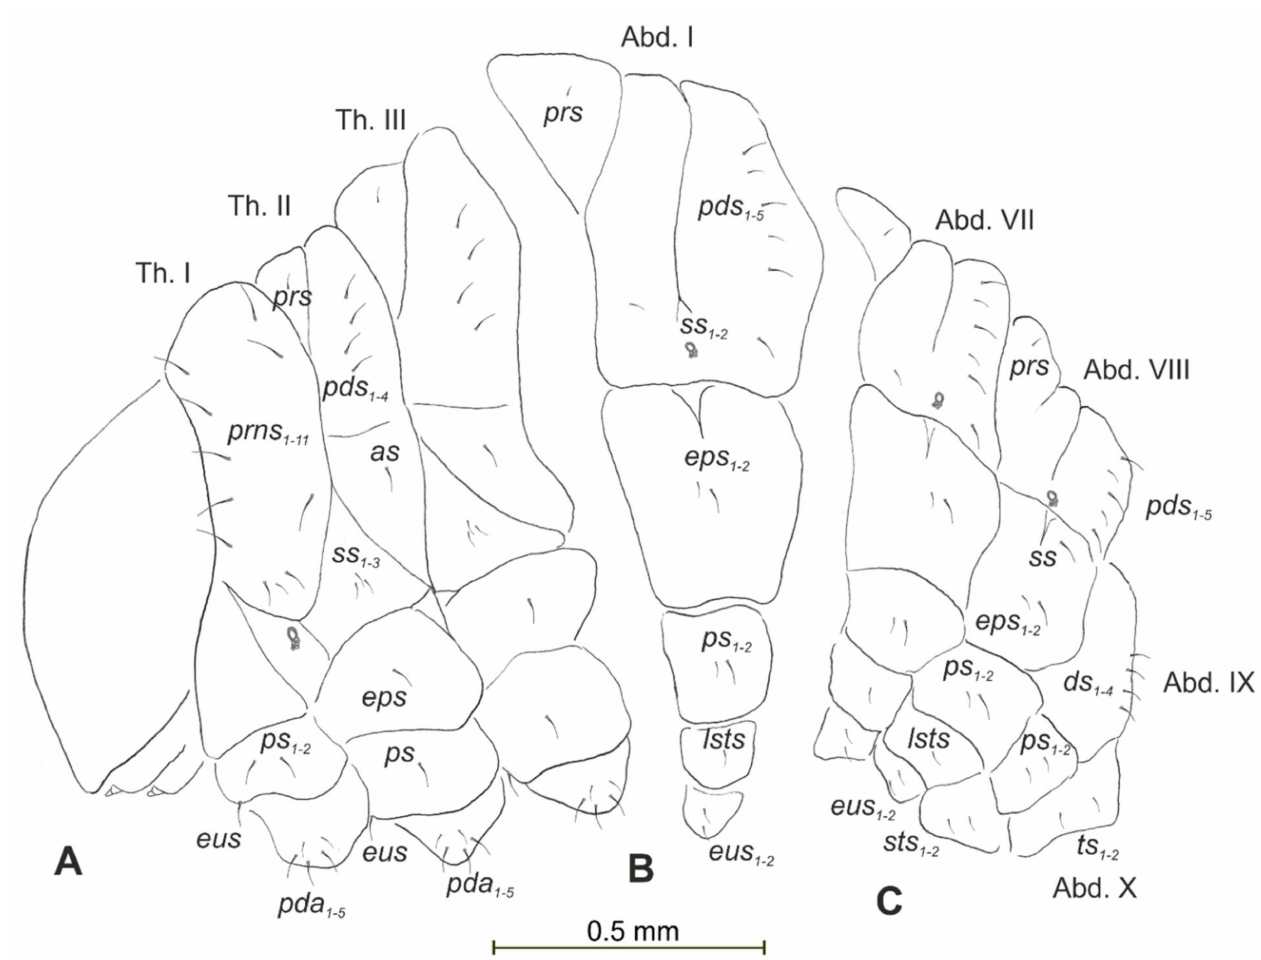
Figure 12. Rhinocyllus alpinus mature larva, chaetotaxy. ( A )—lateral view of thorax; ( B )—lateral view of abdominal segment I; ( C )—lateral view of abdominal segments VII–X (Th. I–III—thoracic segments 1–3, Abd. I–X—abdominal segments 1–10, setae: as —alar, ds —dorsal, ps —pleural, eps —epipleural, eus —eusternal, pda —pedal, pds —postdorsal, prns —pronotal, prs —prodorsal, ss —spiracular, sts —sternal, ts